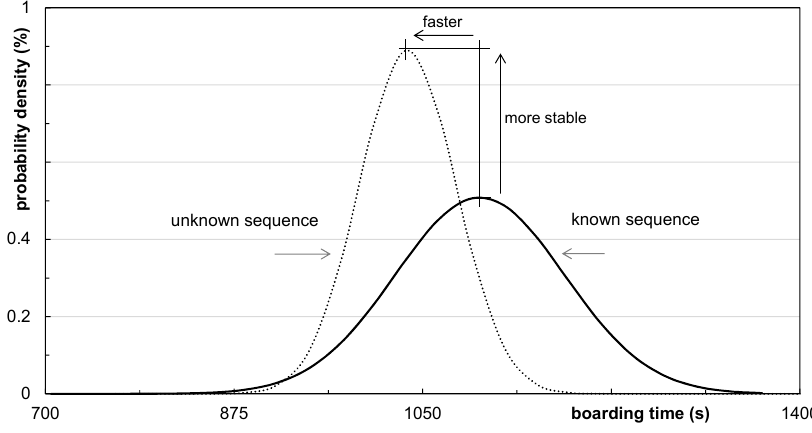
Figure 17. Boarding time distribution with unknown and known arrival sequence of passengers.